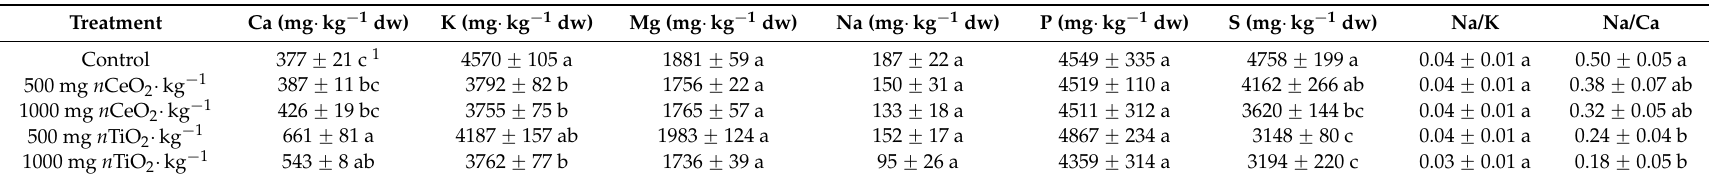
Table 6. Concentration of macro-nutrients, Na, and Na/K and Na/Ca ratios in barley kernels at ripening from main shoot grown in soil treated with none (Control),